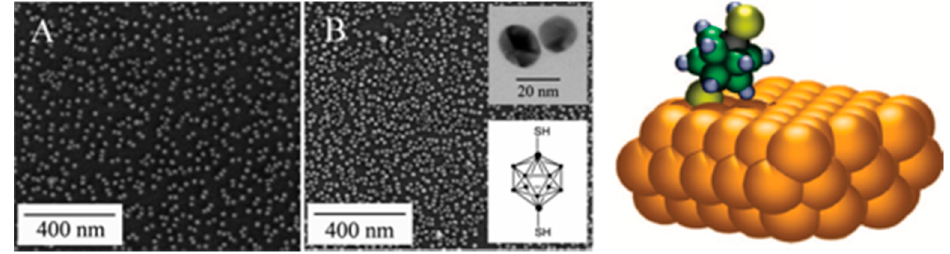
Figure 1. SE TEM images ( A and B ) of Au-NPs functionalized by the carboranethiol 1,12-(HS)2-1,12- C2B10H10 and the side view of space-filling models of same carboranethiol drawing in the capture on a gold (111) surface. Reproduced with permission from [ 82 ] , ACS